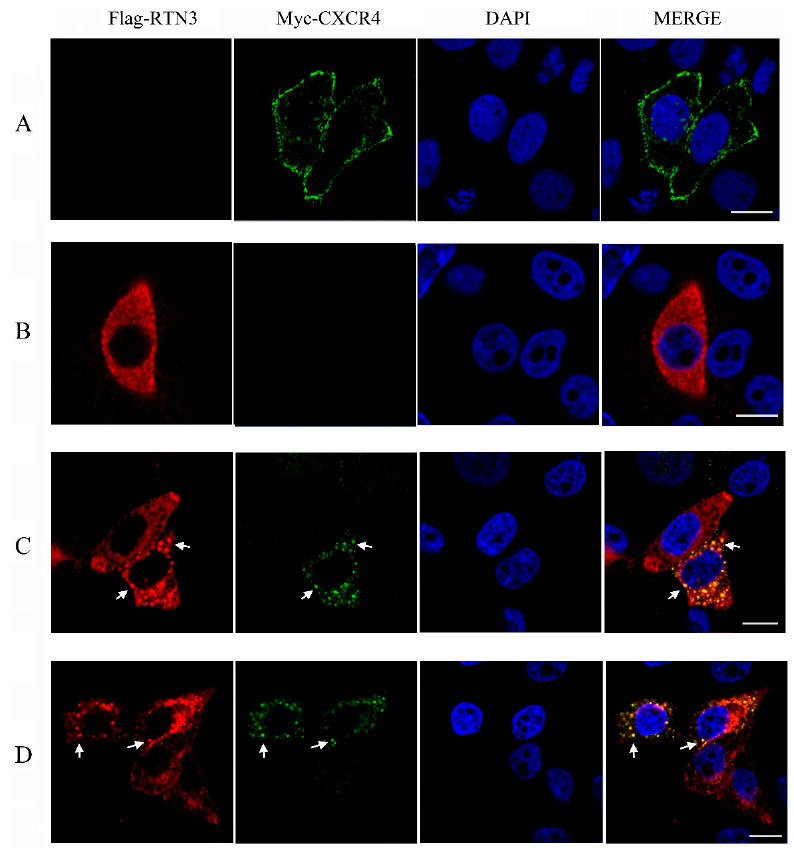
Figure 3. Translocation of CXCR4 in HeLa cells. ( A , B ) The subcellular localization of hCXCR4 and hRTN3. HeLa cells were transfected with pcDNA3.1 ‐ Myc ‐ hCXCR4 ( A ) and pCMV ‐ Flag ‐ hRTN3 ( B ). ( C , D ) Translocation and colocalization of CXCR4 and RTN3. HeLa cells were co ‐ transfected with human Myc ‐ CXCR4 and Flag ‐ RTN3 ( C ) or with zebrafish Myc ‐ CXCR4b and Flag ‐ RTN3 ( D ). After 48 h, the transfected cells were fixed and subjected to immunofluorescence assay using anti ‐ Myc mouse monoclonal antibody (mAb), anti ‐ Flag mAb, and 4 ′ ,6 ‐ diamidino ‐ 2 ‐ phenylindole (DAPI). The results of subcellular localization were screened using confocal laser ‐ scanning microscopy. Arrows indicate puncta in HeLa cells. Scale bar, 10 µm.